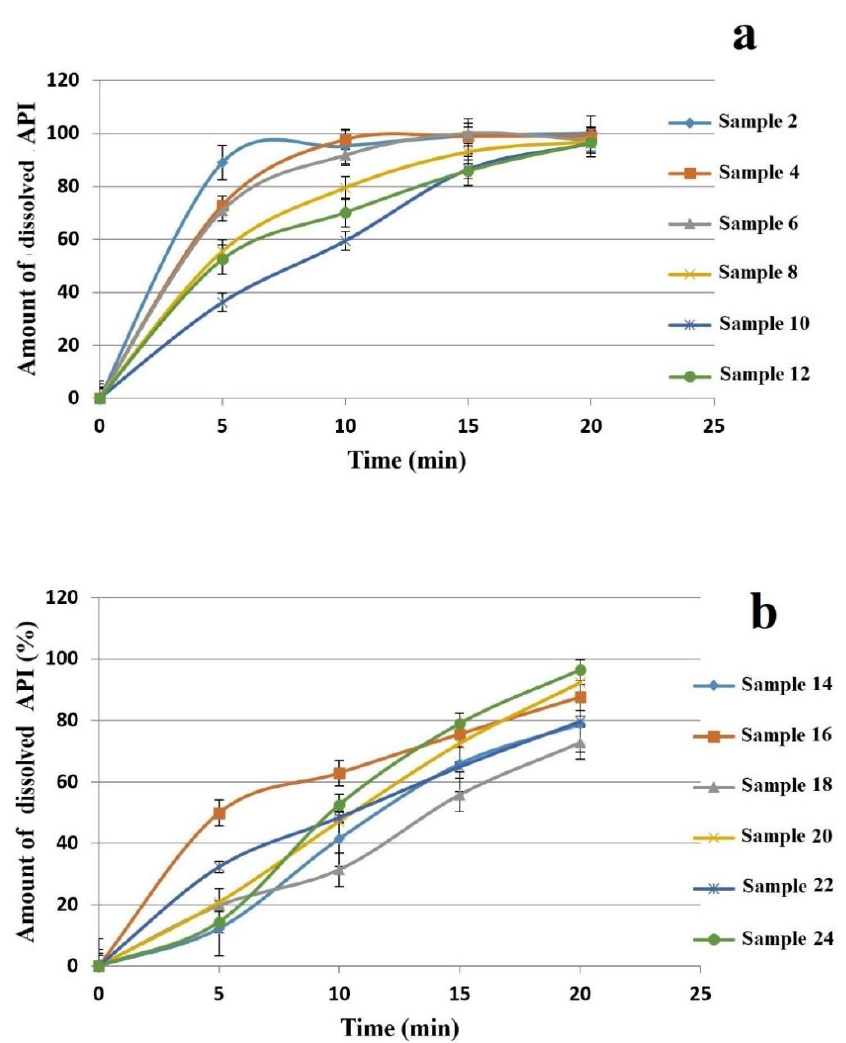
Figure 6. Dissolution curves of prepared polymer films in the first 20 min ( a ): 2% polymer films, and ( b ): 3% polymer films).